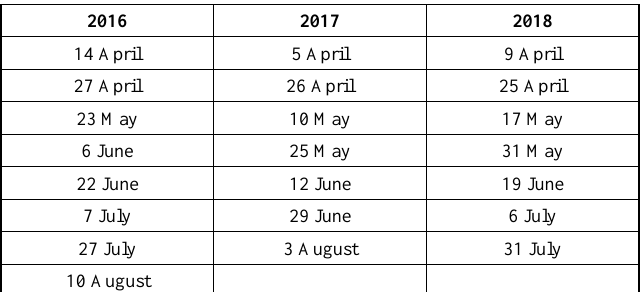
Table 1. Time of treatments (Debrecen, Pallag, 2016-2018)